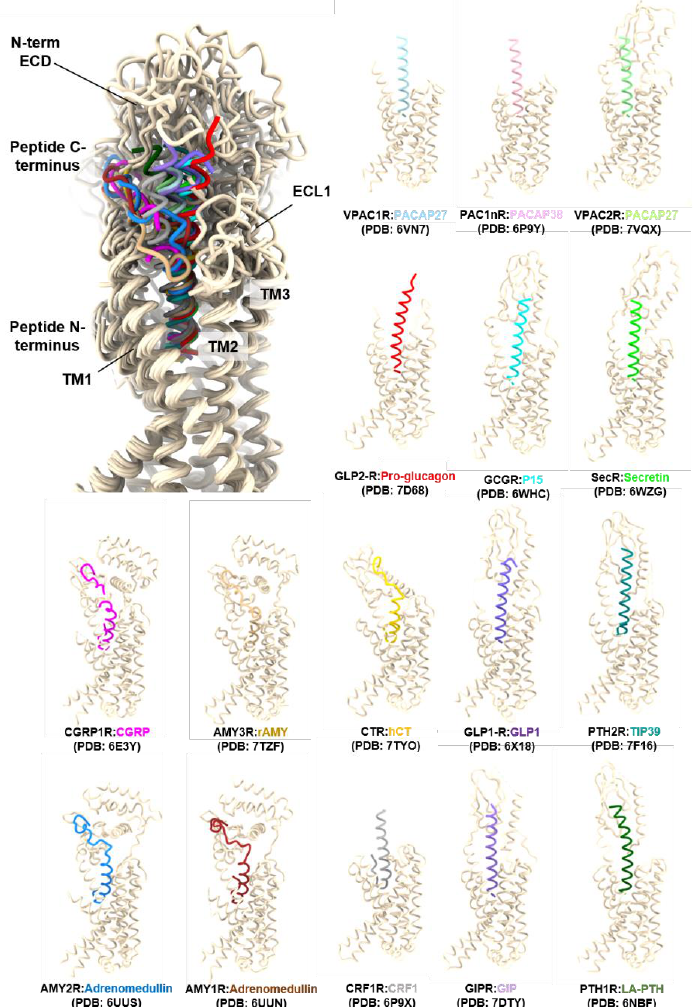
Figure 3. Comparisons of the binding mode of representative peptides bound to Class B1 GPCRs reveal a shared peptide binding mode where the N-terminus of the peptide interacts with the trans- membrane (TM) core and the C-terminus of the peptide interacts with the N-terminal extracellular domain (ECD) and extracellular loops (ECLs) of the receptor [135–137,300–309]. The highest vari- ability of the structures is in the extracellular domains and peptide C-termini (as displayed in the structure overlay in the first panel. Structures were aligned by receptor chains and displayed as ribbons (licorice style) using Chimera X 1.3 [310,311]. G protein subunits are not displayed for clarity. The following models lack extracellular domains due to low resolution: PDB 6VN7, 6P9Y, 7D68, and